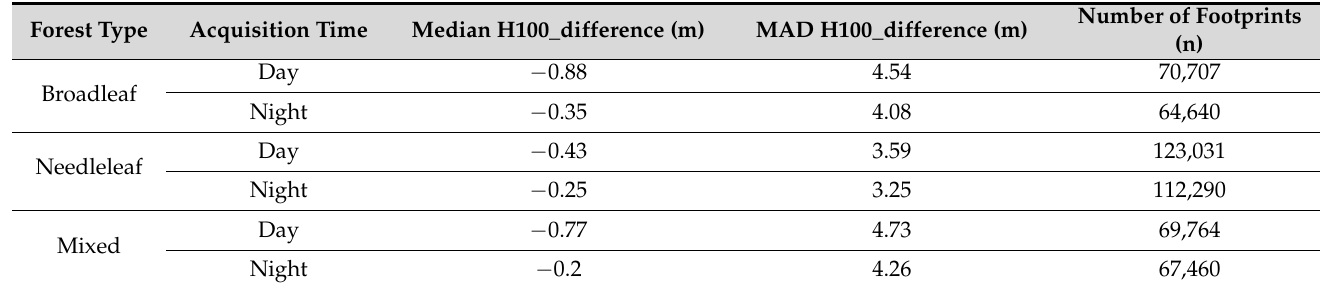
Table 4. Statistics of H100_difference for two groups of datasets based on beam type and acquisition time in three forest types.